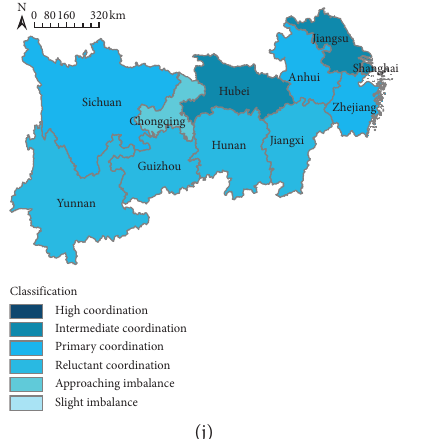
Figure 5: Spatial evolution of DCC. (a) 2009; (b) 2010; (c) 2011; (d) 2012; (e) 2013; (f) 2014; (g) 2015; (h) 2016; (i) 2017; (j)